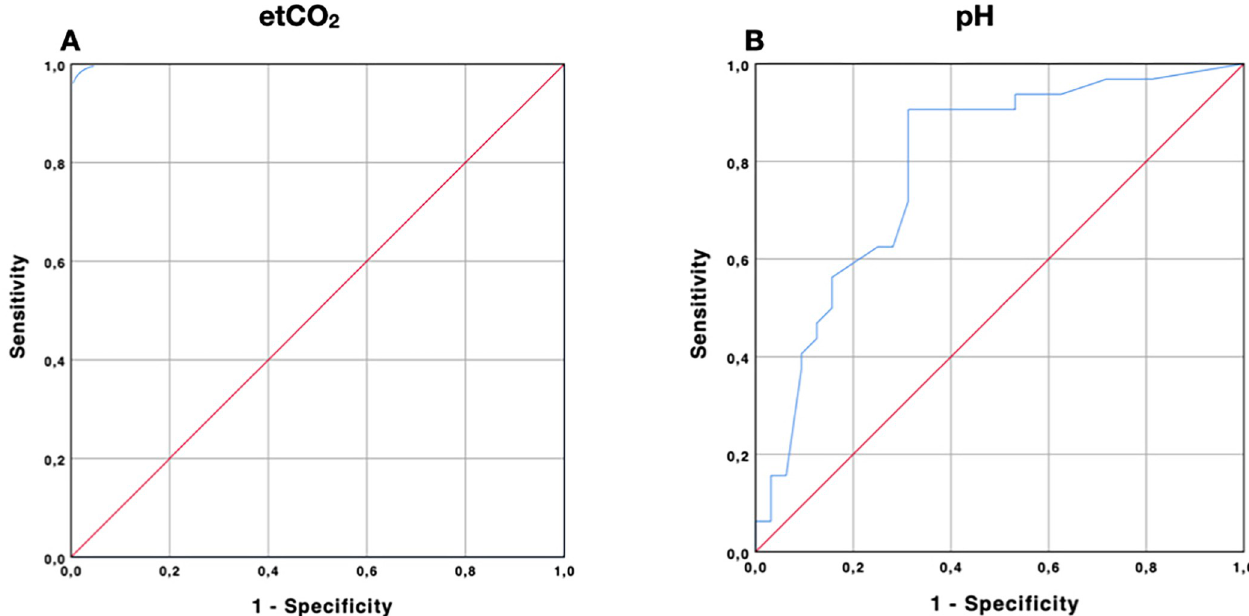
Fig 4. ROC curves of ETCO 2 and pH. Receiver operating characteristic (ROC) curves showing the ability of the ETCO 2 method (Fig 4A) and pH method (Fig 4B) to respectively identify a tracheal NGT misplacement (ROC AUC 1.0, p < 0.001) or a gastric NGT correct placement (ROC AUC 0.79, CI 95% 0.67–0.90, p < 0.001).